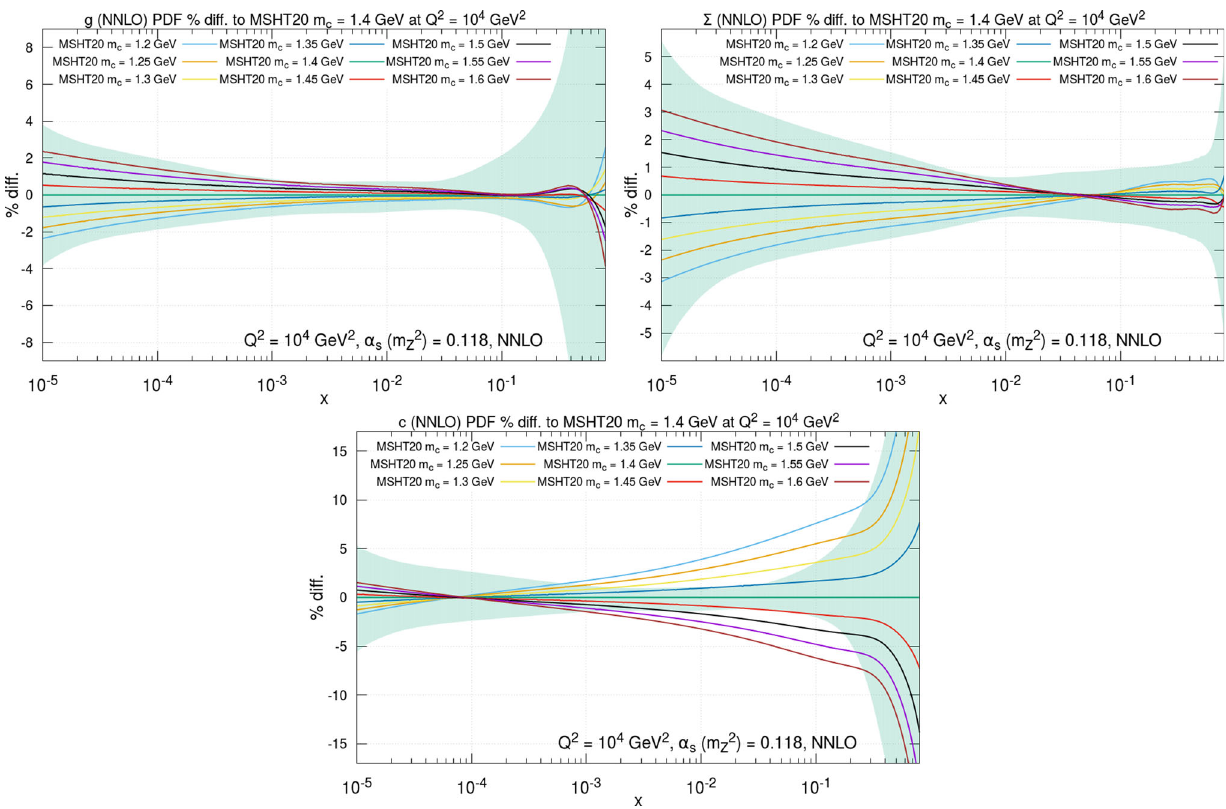
Fig. 24 The m c dependence of the gluon, light-quark singlet and charm distributions at NNLO for Q 2 = 10 4 GeV 2 , compared to the standard MSHT20 distributions with m c = 1 . 4 GeV and m b = 4 . 75